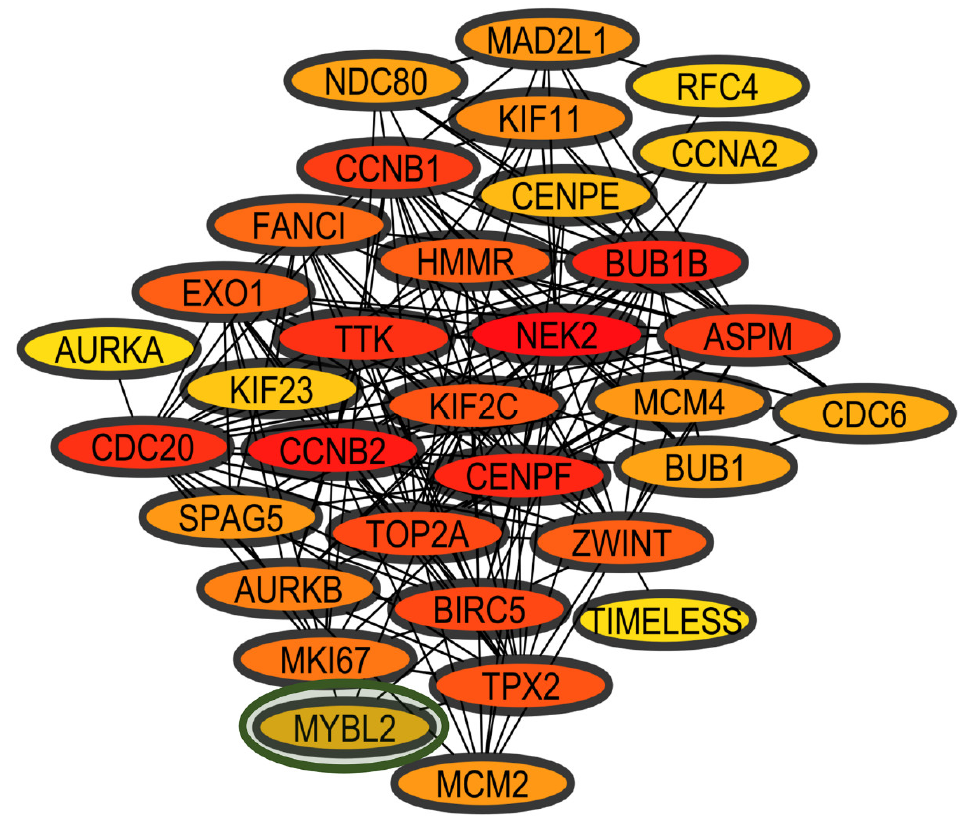
Figure 7. Coexpression network of deregulated winning genes common among the three types of cancer (LC&OC coexpression network). In red are the most connected nodes, in orange the average connected nodes, and in yellow the less connected nodes. The TF is highlighted inside the green oval.